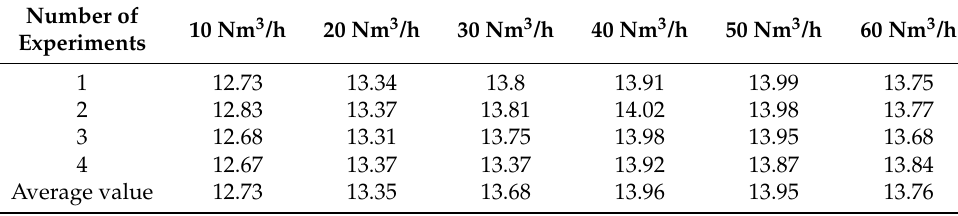
Table 17. Liquid particle size in Case 4 at M 2 ( µ